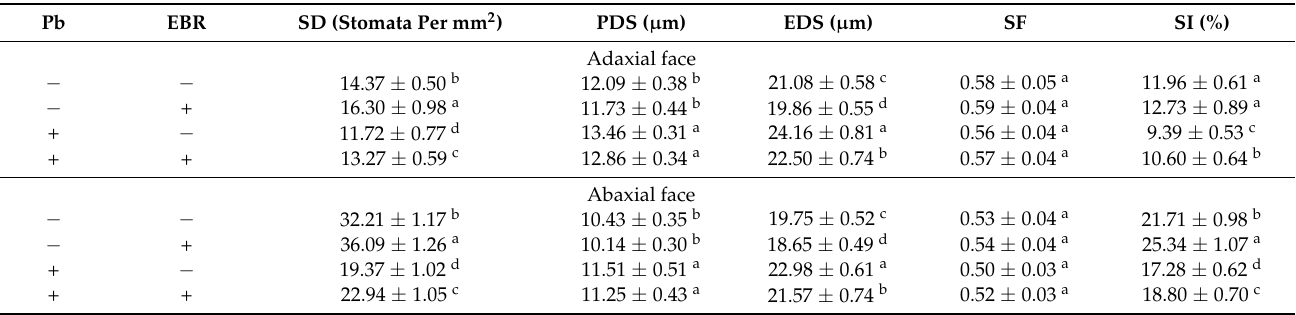
Table 5. Stomatal characteristics in tomato plants treated with EBR and subjected to Pb toxicity.